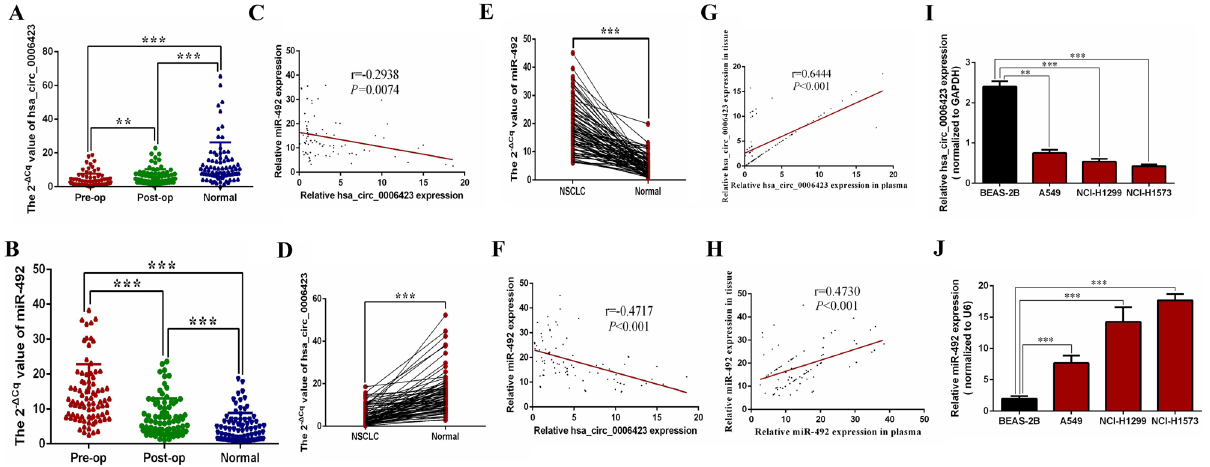
Figure 3. Expression levels of hsa_circ_0006423 and miR-492 in NSCLC plasma, tissue samples, and cell lines. ( A ) Expression levels of hsa_circ_0006423 in the preoperative group were significantly lower than those in the postoperative and the healthy controls group ( n = 82), and expression levels of hsa_circ_0006423 in the postoperative group were significantly lower than those in the healthy control group ( n = 82). ( B ) The expression levels of miR-492 in the preoperative group were significantly higher than those in the postoperative and the healthy controls group ( n = 82), and the expression levels of miR-492 in the postoperative group were significantly higher than those in the postoperative group the healthy control group ( n = 82). ( C ) Pearson correlation analysis revealed that expression levels of hsa_circ_0006423 and miR-492 in 82 NSCLC plasma samples were negatively correlated. ( D ) Expression levels of hsa_circ_0006423 in NSCLC tissues were significantly lower than adjacent tissues ( n = 82). ( E ) Expression levels of miR-492 in NSCLC tissues were significantly higher than adjacent tissues ( n = 82). ( F ) Pearson correlation analysis found that the expressions of hsa_circ_0006423 and miR-492 in 82 NSCLC tissue samples were negatively correlated. ( G ) Pearson correlation analysis found that the expressions of hsa_circ_0006423 in 82 NSCLC plasma and tissue samples were postively correlated. ( H ) Pearson correlation analysis found that the expressions of miR-492 in 82 NSCLC plasma and tissue samples were postively correlated. ( I ) Hsa_circ_0006423 in NSCLC cell lines (A549, NCI-H1299 and NCI-H1573) lower expression than the normal bronchial epithelial cell line BEAS-2B. ( J ) miR-492 in NSCLC cell lines (A549, NCI-H1299 and NCI-H1573) showed higher expression than normal bronchial epithelial cell line BEAS-2B. ** P < 0.01; *** P <